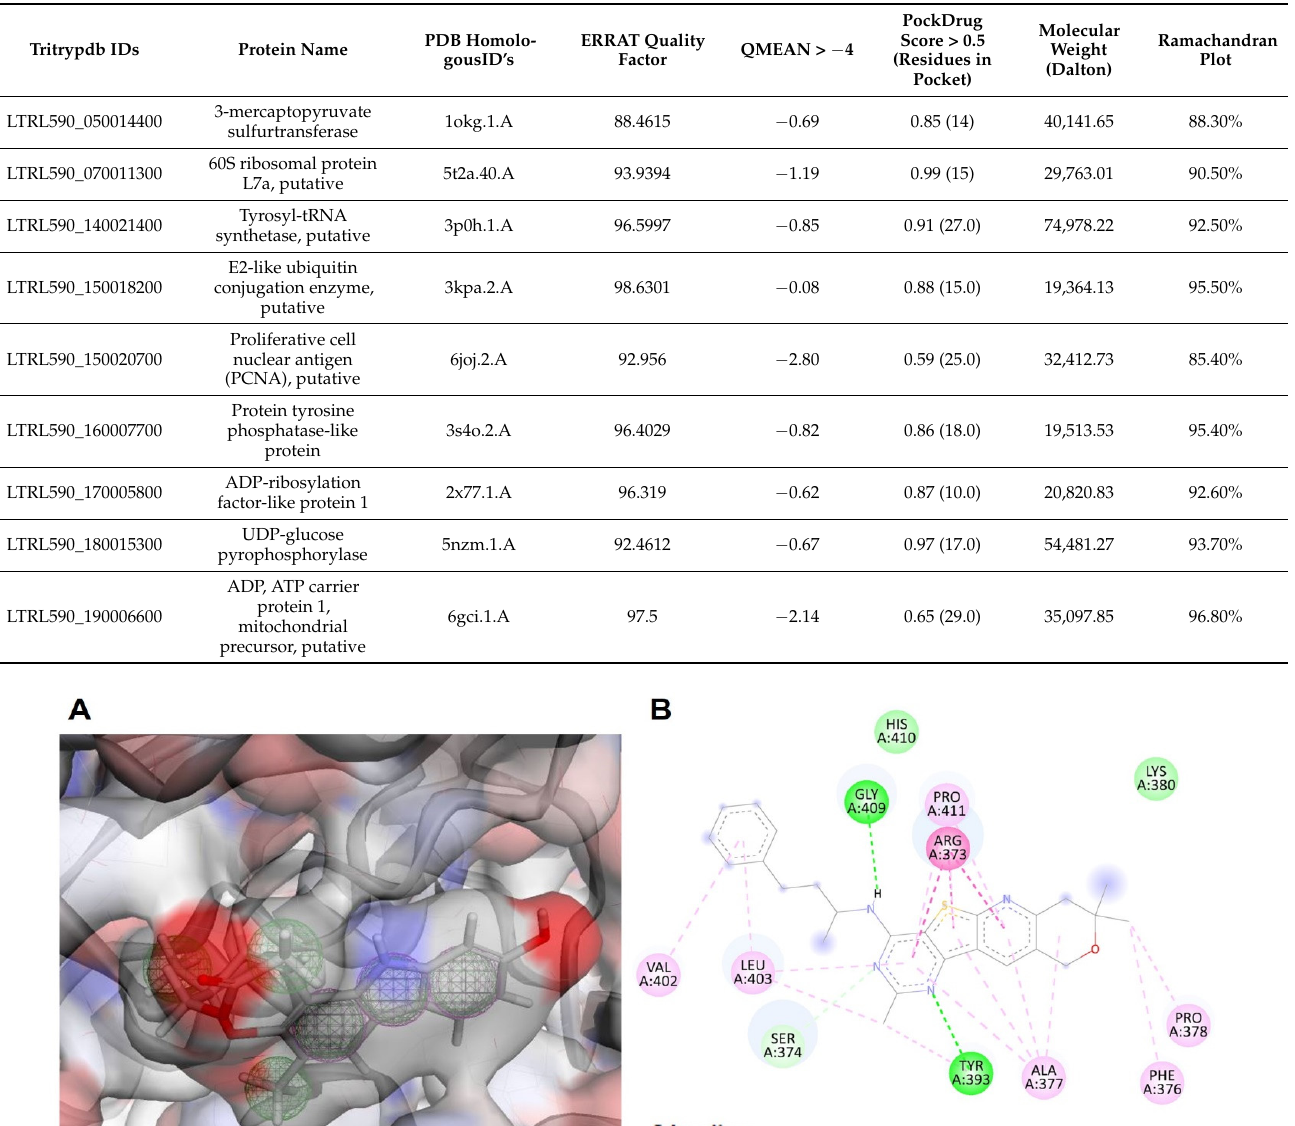
Table 1. The molecular modeling, 3D structure validation, and druggability analysis of the prioritized shortlisted proteins of L. tropica .